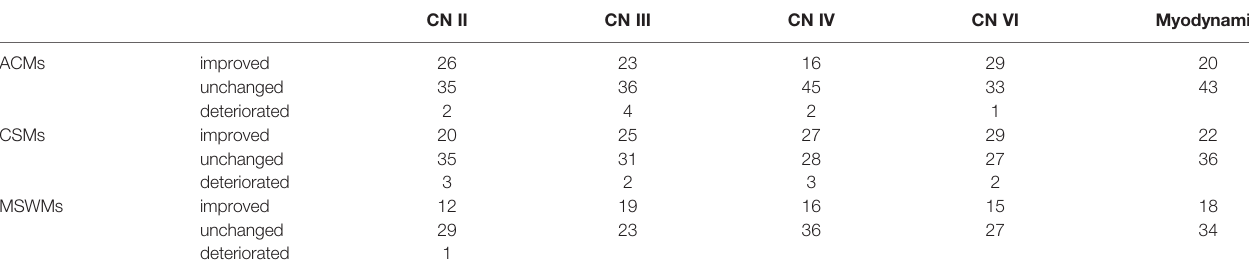
TABLE 3 | The number of patients with CN function and myodynamia change at the latest follow-up.